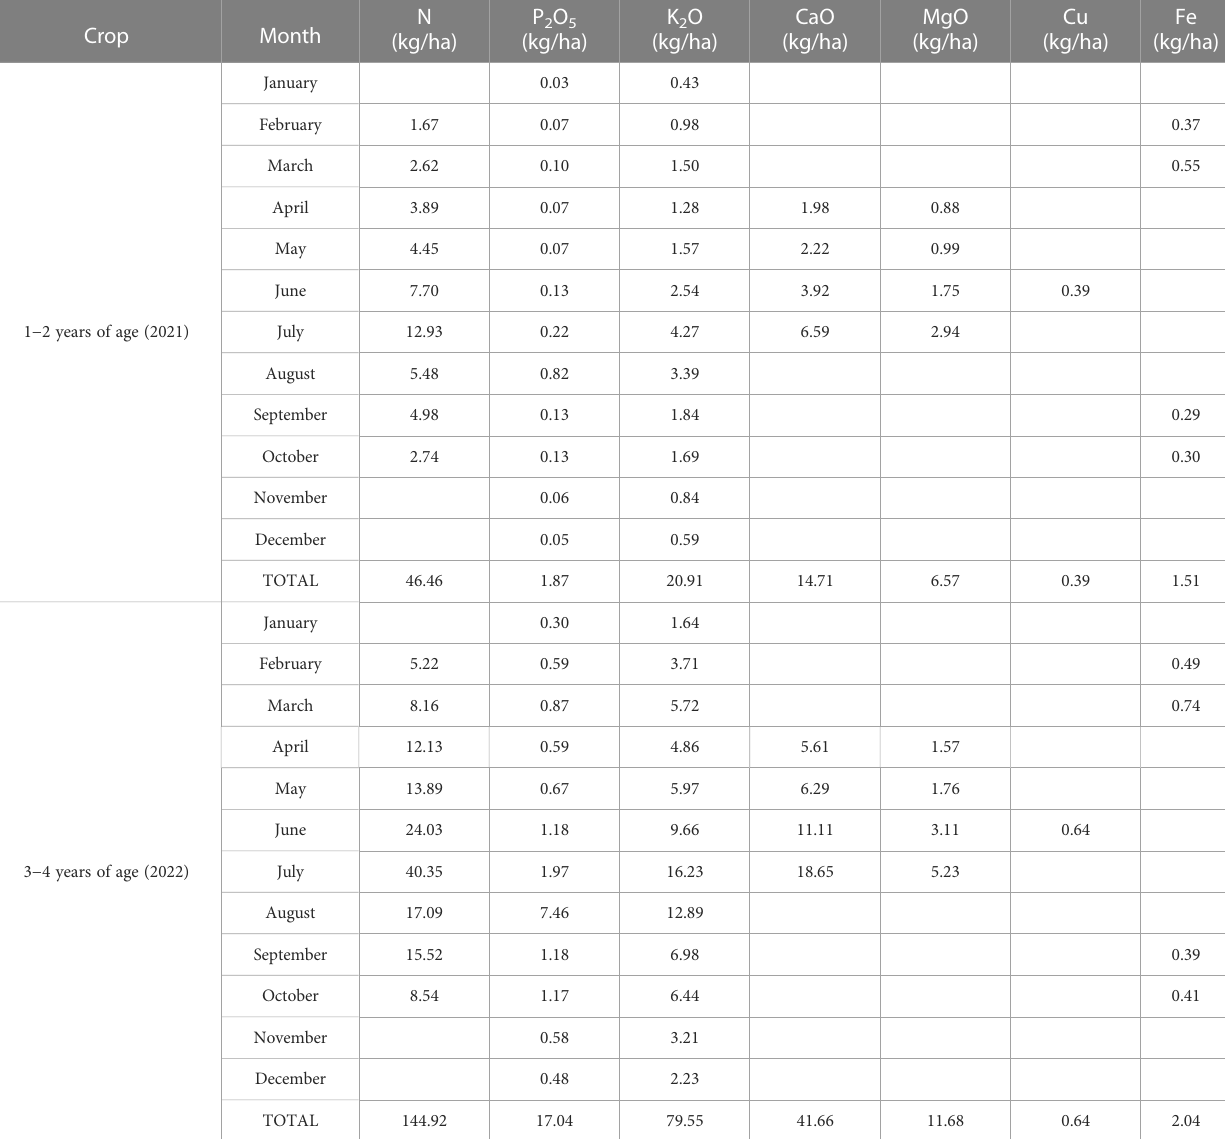
TABLE 3 Monthly nutrient requirements for Citrus x paradisi (var. Rio Red) recommended by the fi eld technician. Crop Month